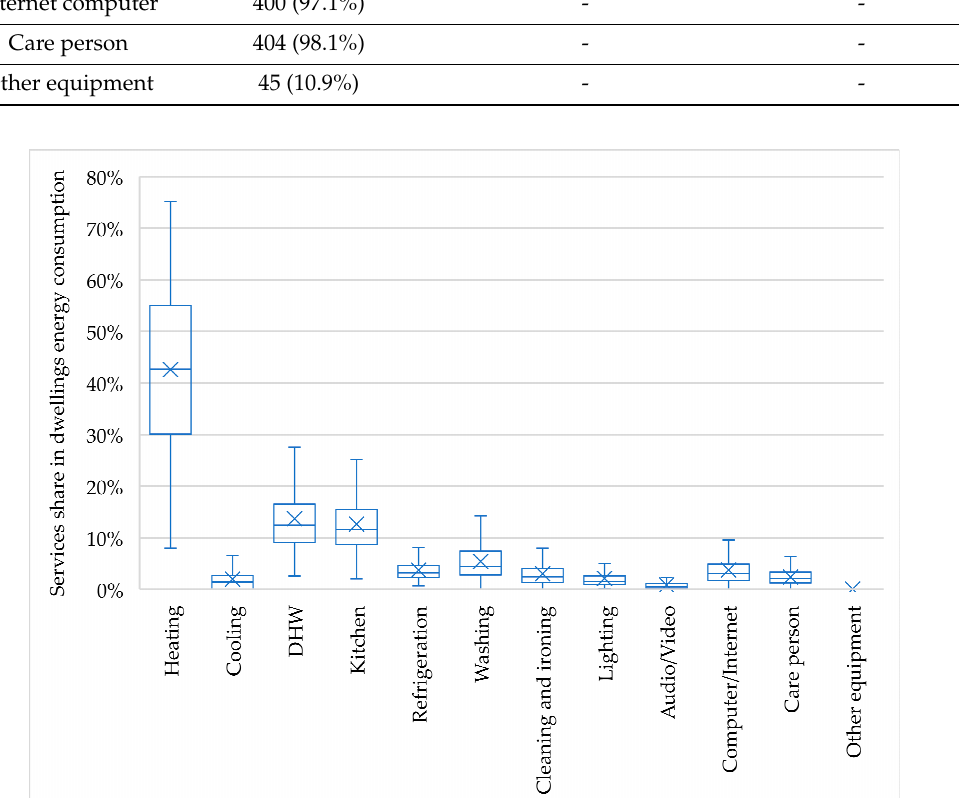
Figure 7. Services share in dwellings energy consumption.